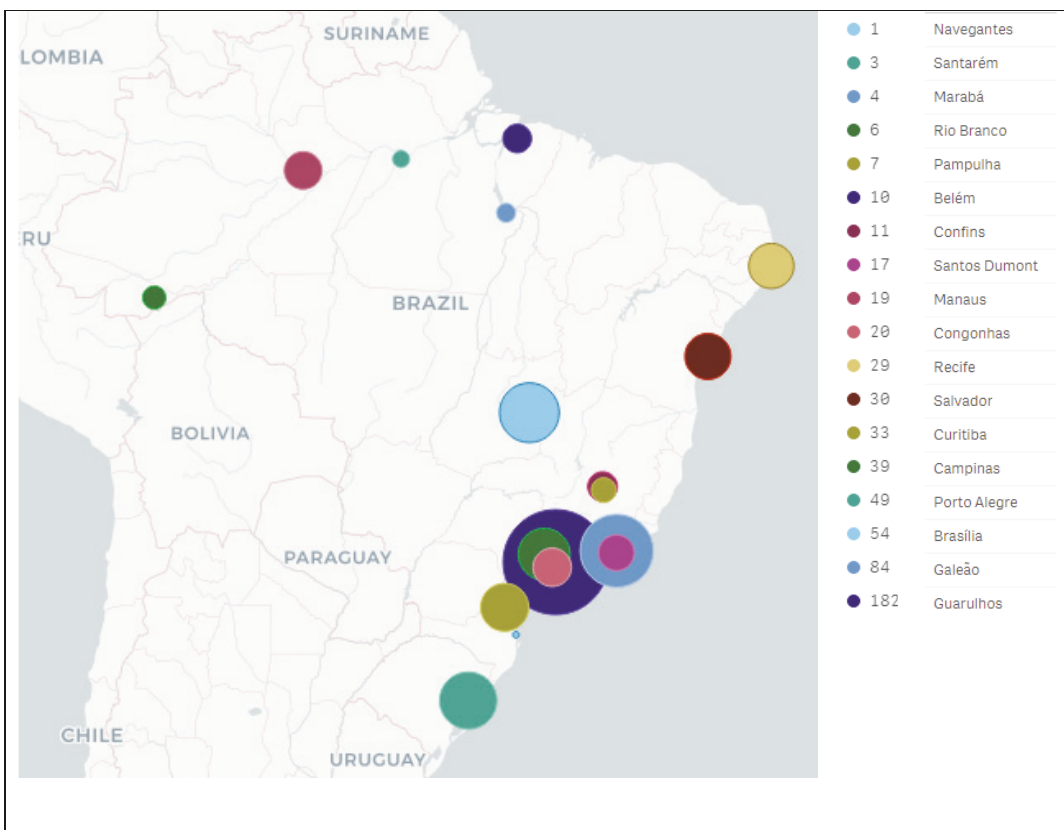
Figure 1: Distribution of questionnaire respondents, over 18 Brazilian airports in the years of 2013 and 2014.